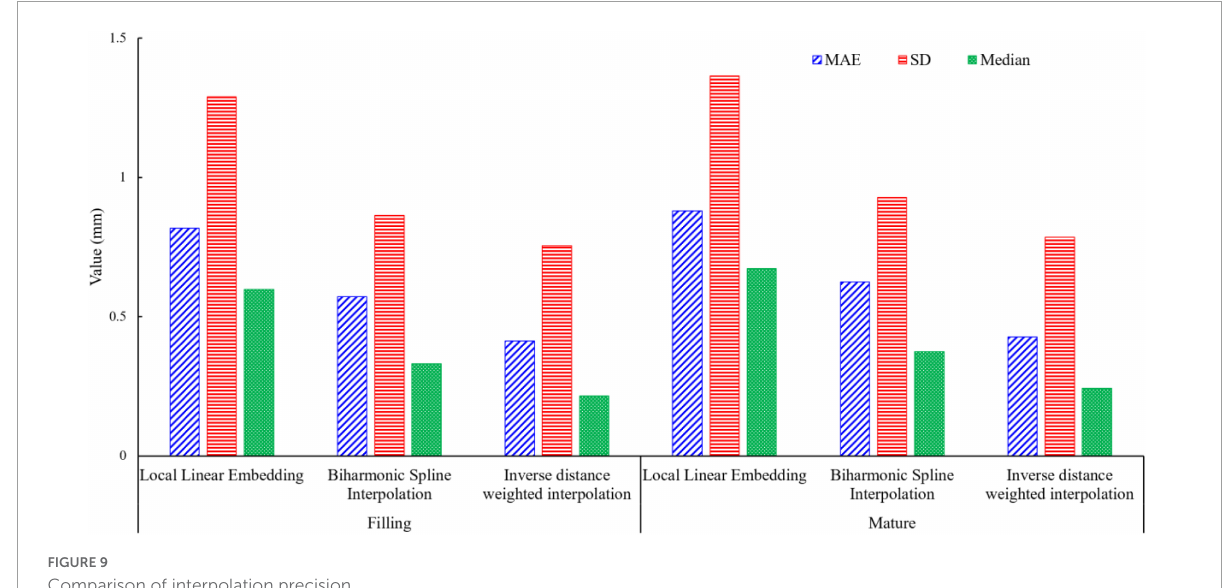
FIGURE9 Comparison of interpolation precision.